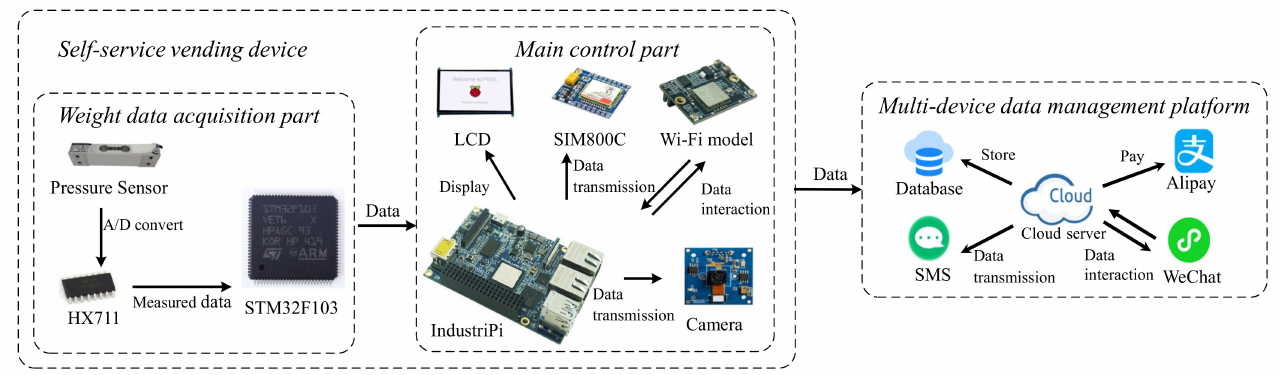
Figure 1. The architecture of the